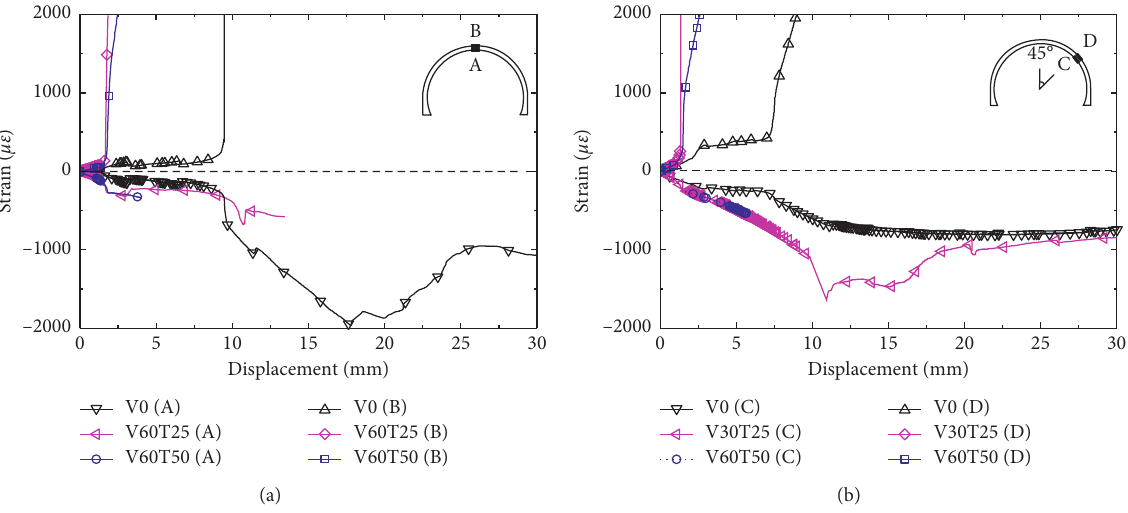
Figure 17: Strain-displacement curve of the lining with combined defects: (a) crown and (b)